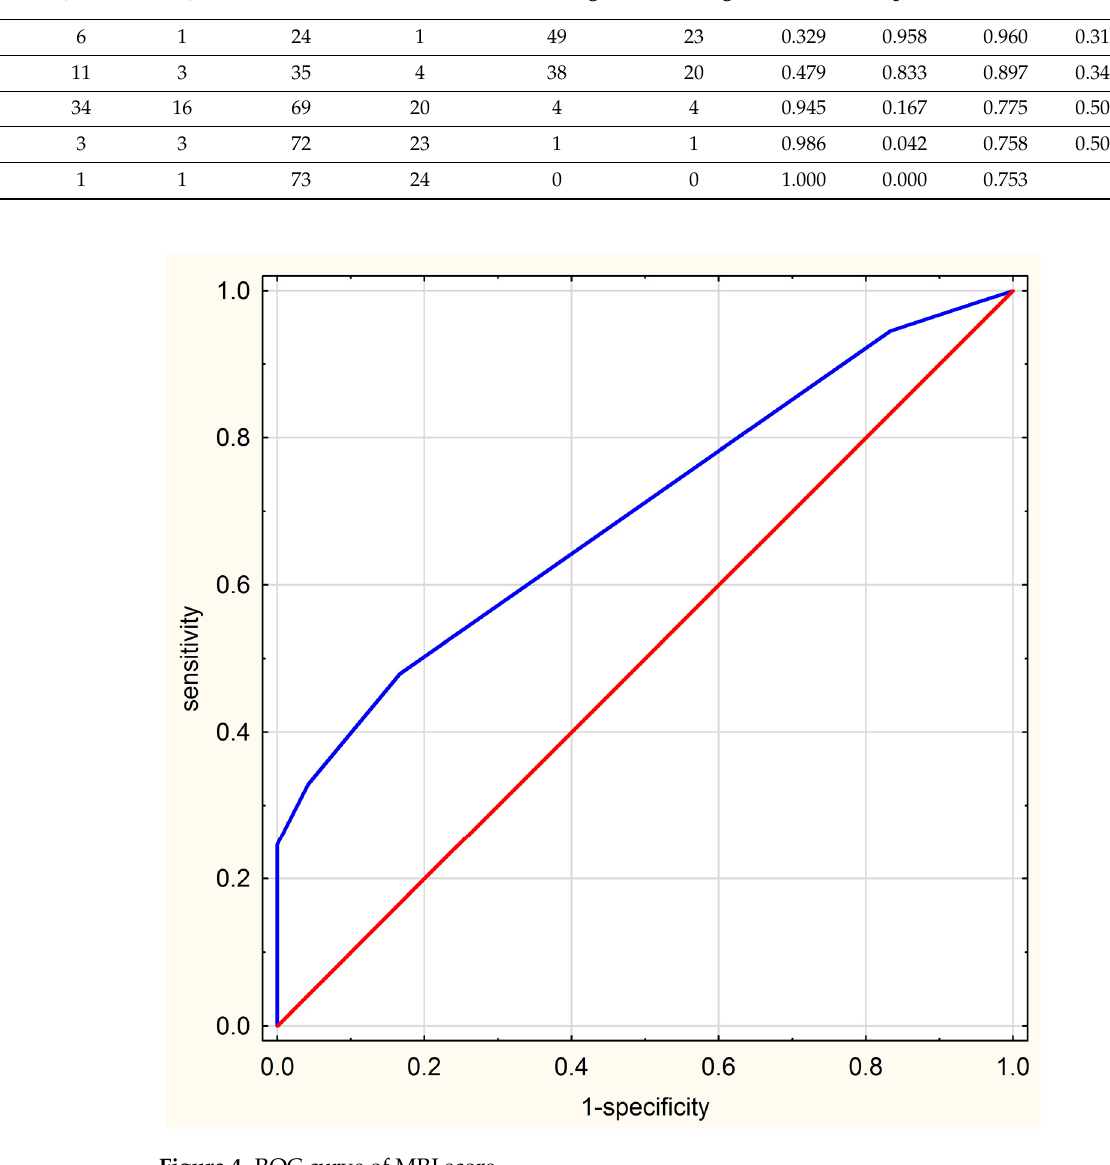
Figure 4. ROC curve of MRI score.